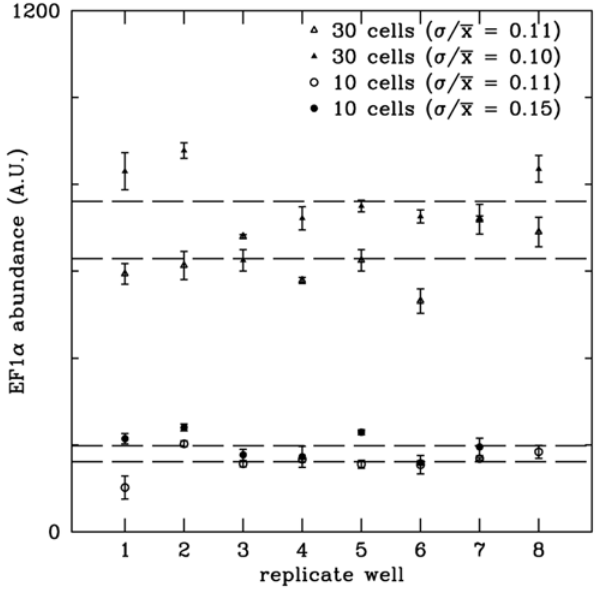
Figure 3. Precision of replicate real-time processing of single cells. Two sets of either 10 or 30 cell-samples were sorted by flow cytometry, lysed and then aliquoted into 8 aliquots. cDNA synthesis was performed independently for each aliquot and EF1 a expression was measured by real-time PCR in triplicate on each aliquot. The replicates of each set of samples are shown (1.3-cell equivalents, open and filled triangles; 3.8-cell equivalents, open and filled circles). Based on this and similar experiments, we conservatively assign a fractional error of 15% to the cDNA synthesis step of our process.